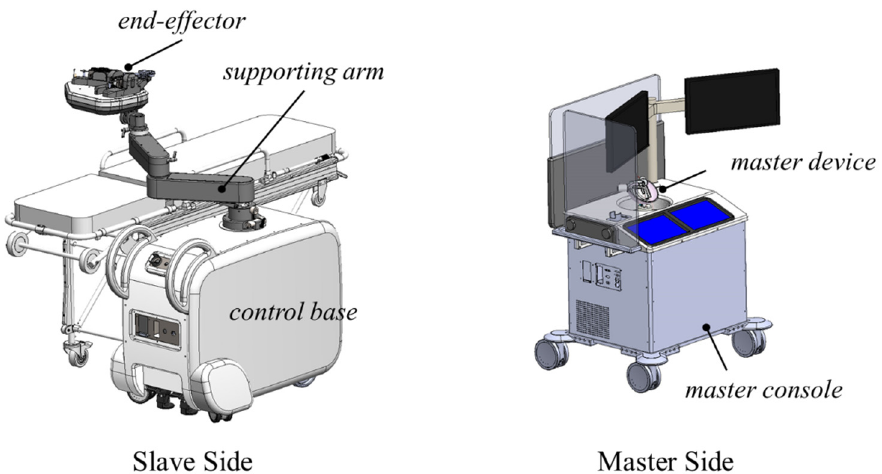
Figure 1. Overall configuration of the system. The translation mechanism advances or retracts vascular instruments by axially rotat- ing the tightly pressed roller pairs. The rotation mechanism rotates vascular instruments by rubbing the roller pair. The roller mechanism was chosen for uninterrupted translational motion control of the vascular instruments